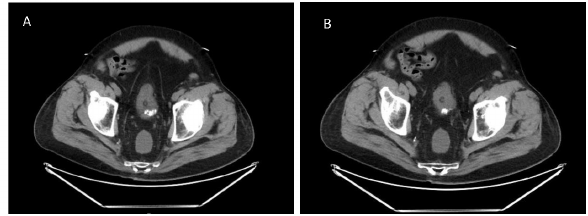
Figure 1. A: CT image of bladder wall calcification on the posterior bladder wall. B: Calcification of the posterior inferior bladder